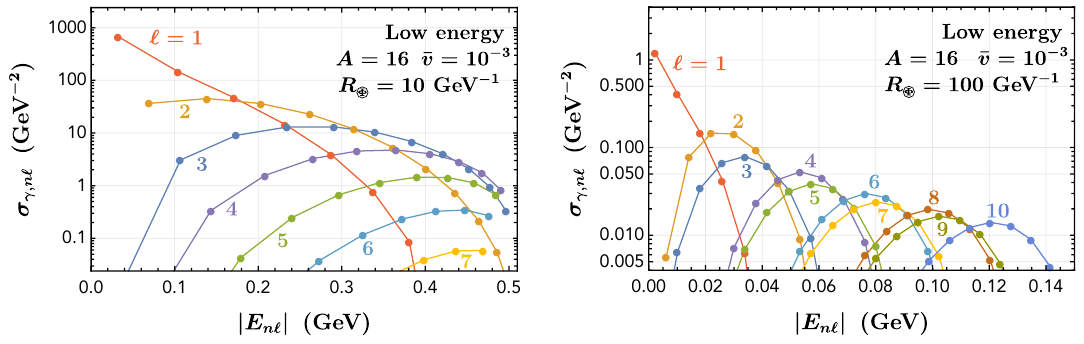
= 10 GeV (cid:0) 1 (left) and (cid:8)